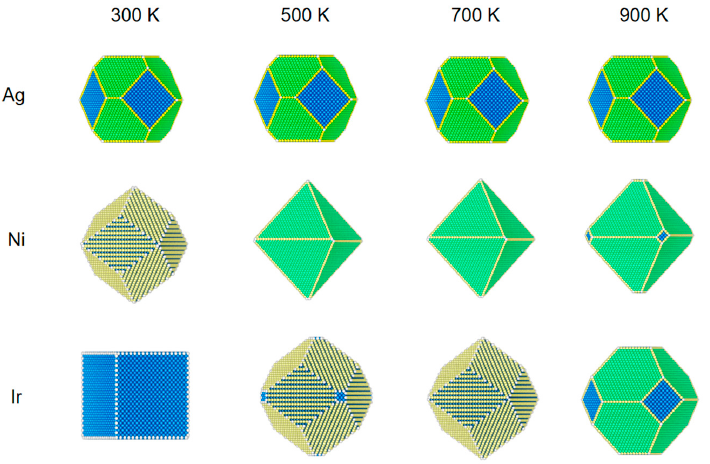
Figure 2. The structural evolution of 5 nm metal NPs (Ag, Ni, and Ir) at different temperatures and 100 Pa of CO.